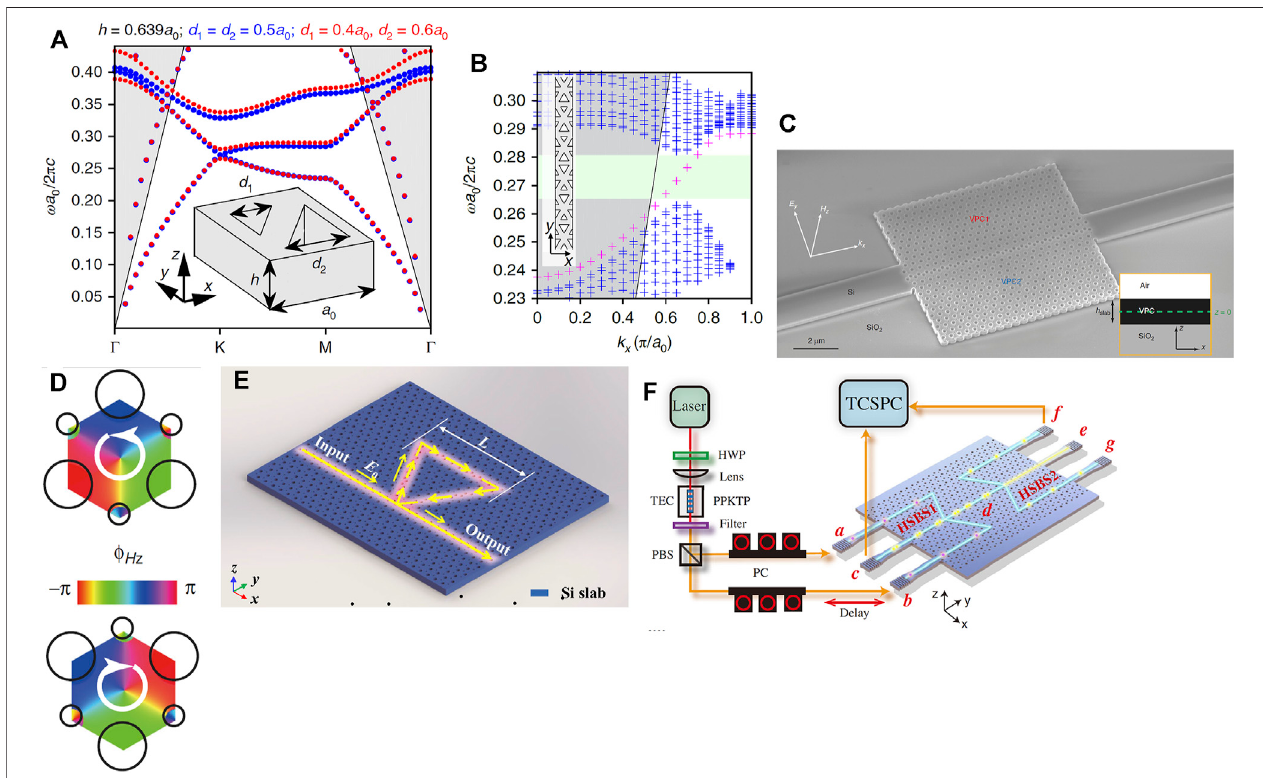
FIGURE 3 | (A) Band structures of the valley photonic crystal slab with triangular air holes. The inset represents the unit cell structure composed of two unequal triangularairholes[95]. (B) Banddiagramofedgestatesintheinterfacebetweentwodistinctvalleyphotoniccrystals.Themagentacurveindicatestheedgestate.Thegreen and blueregions indicatethe bandgapand bulkbands,respectively. (C) Schematicofthe topologicalchiralinterfacebyconnectingtwotopologicallydistinctvalleyphotonic crystal regions marked by “ VPC1 ” and “ VPC2 ” [99]. (D) Calculated phase distribution of Hz fi eld for differently perturbed honeycomb lattice. (E) Schematic of the topologicalnotch fi ltercontainingatriangular-loopringresonator,inwhichonlyoneedgestatepropagatesforwardandthendirectionallycoupledtotheringresonatormode due to valley-polarization locking [71]. (F) Experimental setup and structural image of a complex topological structure with two harpoon-shaped beam splitters